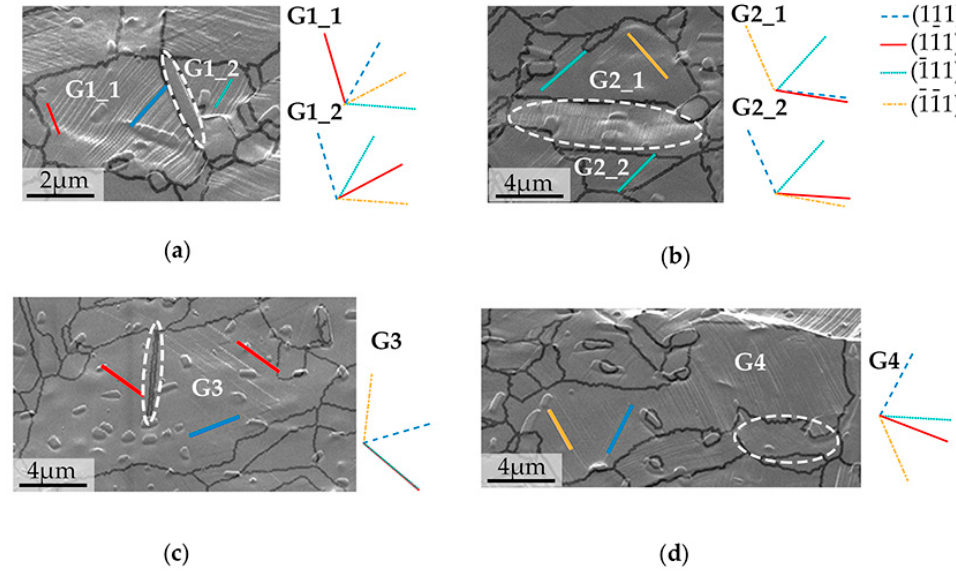
Figure 8. Slip systems analysis on GOI. SEM of activated slip systems and prediction traces based on EBSD data on ( a ) G1_1, G1_2, ( b ) G2_1, G2_2, ( c ) G3 and ( d ) G4. Twins in white dashed oval.